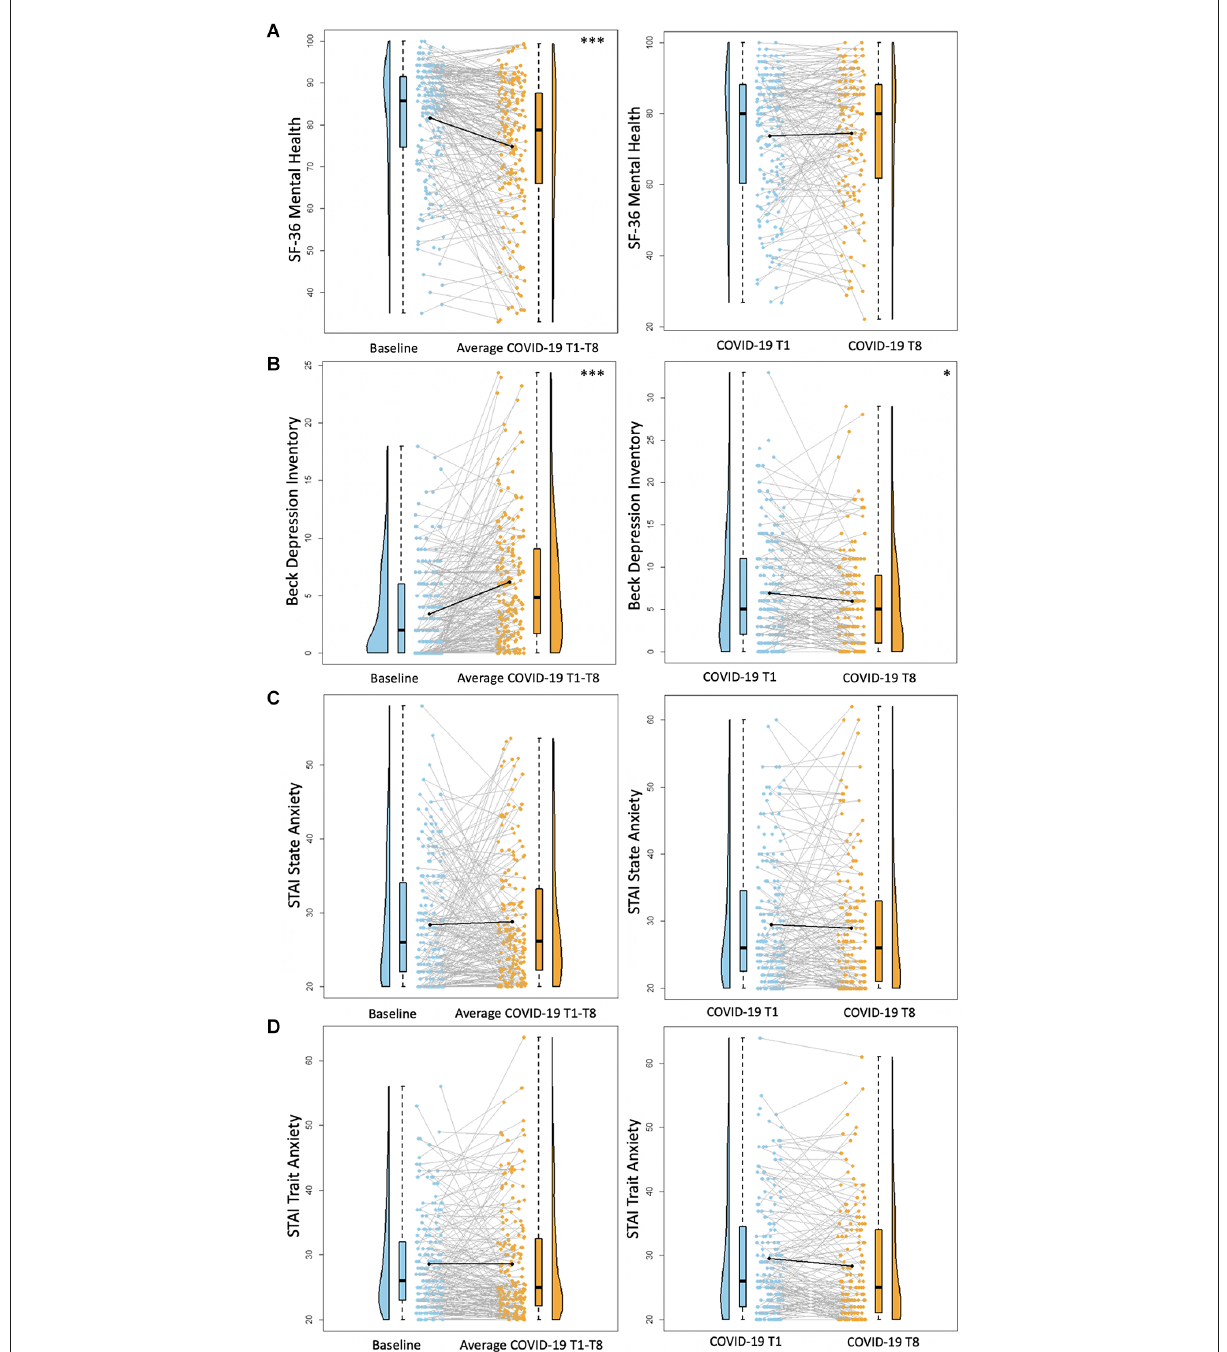
FIGURE2 Psychosocial results. Plots depicting the raw distribution of data points collected for (A) Short Form 36 Health Survey Questionnaire (SF- 36)—Mental Health Summary, (B) Beck Depression Inventory—Second Edition, (C) State-Trait Anxiety Inventory (STAI)—State Anxiety, and (D) State-Trait Anxiety Inventory—Trait Anxiety. The plots on the left side of the panel represent change from pre-pandemic baseline to during the pandemic (average of COVID-19 timepoints 1–8), while the plots on the right side of the panel represent change throughout the pandemic (COVID-19 timepoint 1 vs. timepoint 8). ∗ p < 0.05, ∗∗∗ p < 0.001.